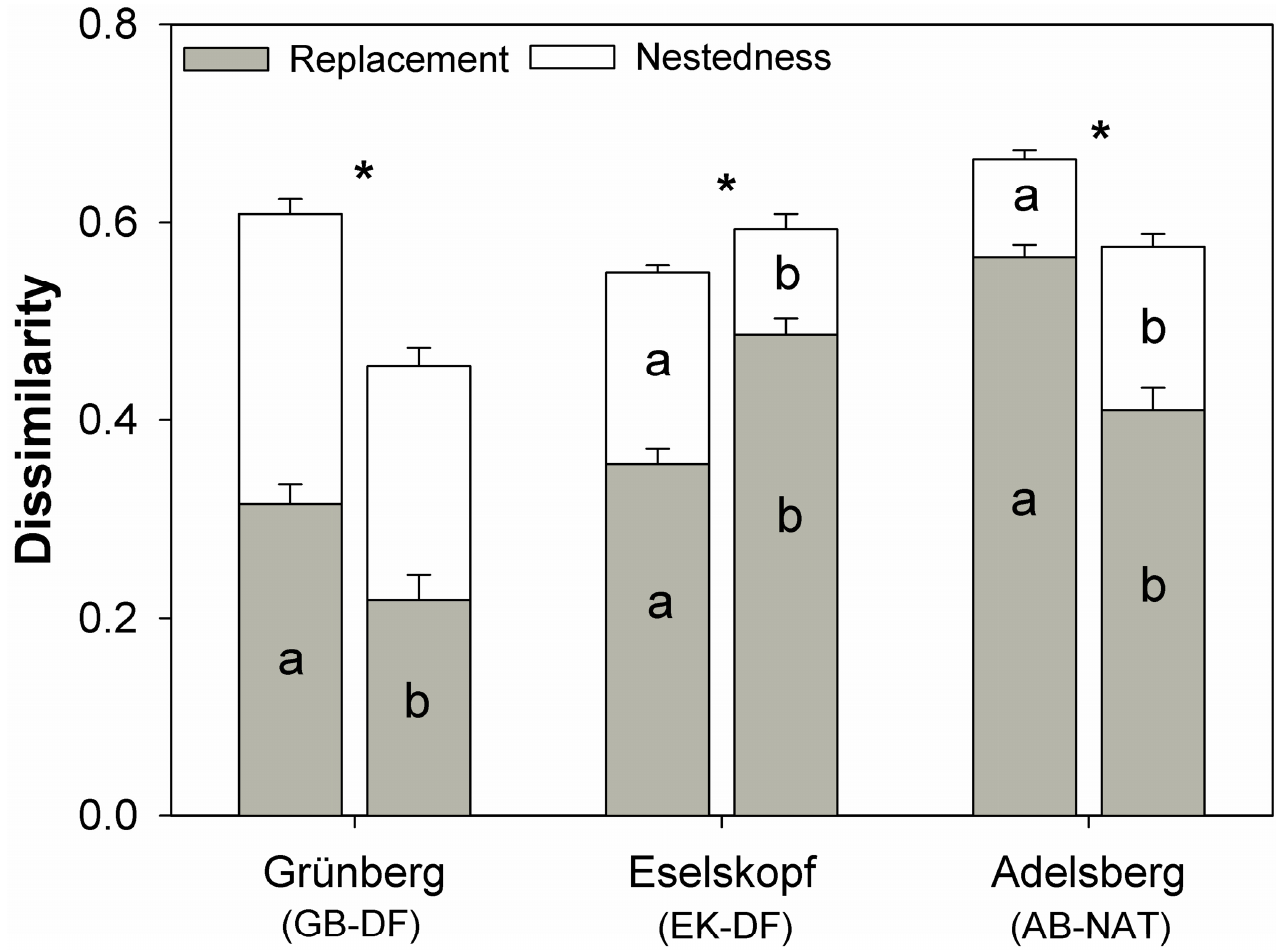
Figure 3. Mean pairwise Jaccard dissimilarity for the old (left bar) and more recent (right bar) survey in the three SFR. The dissimilarity was partitioned into the replacement and nestedness component according to Baselga [64]. * Marks a significant difference ( p < 0.05) between the surveys for the overall Jaccard-dissimilarity. Different letters show significant differences ( p < 0.05) for replacement and nestedness component between the old and recent